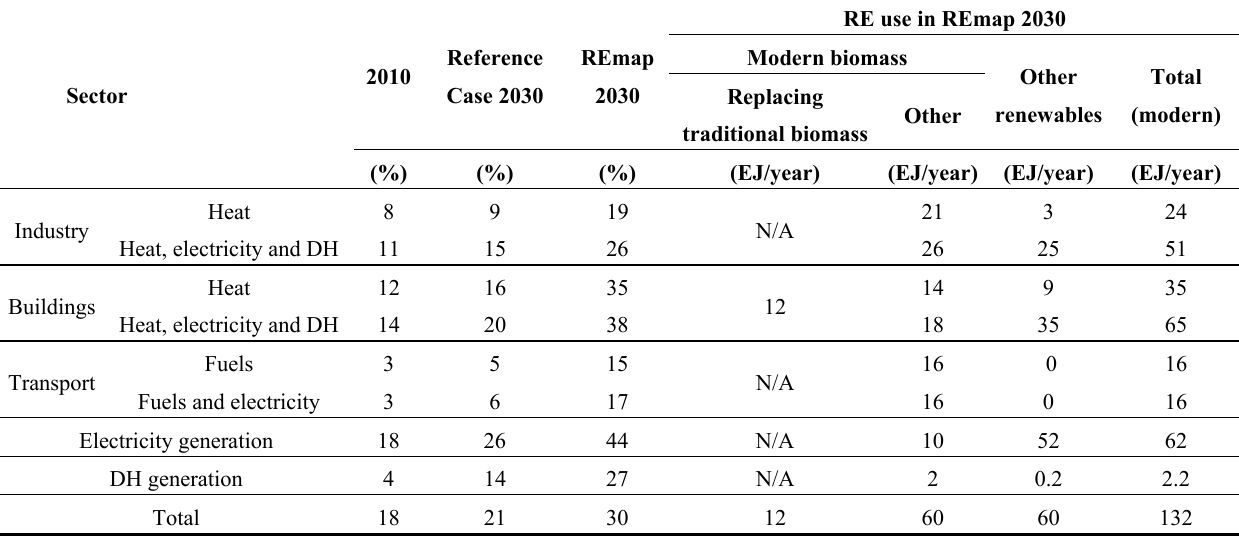
Table 3. RE generation and RE use in end-use sectors, in 2010 and for the Reference Case and REmap in 2030 (in absolute values and